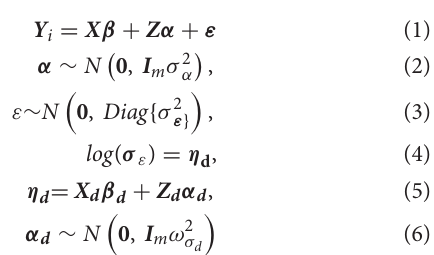
TABLE 2 | Definition of feeding behaviors